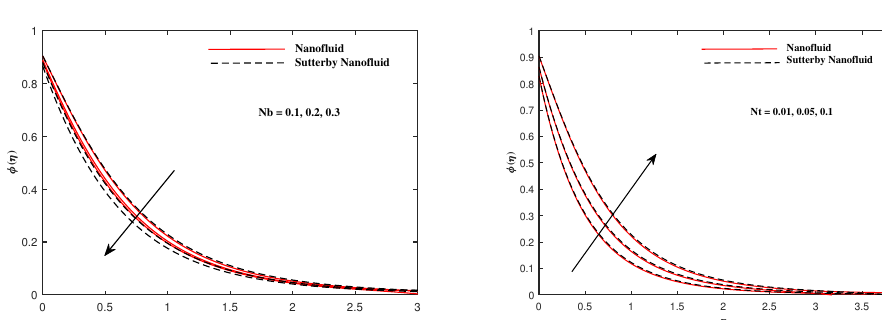
Figure 11. φ ( η ) fluctuate with Sc and A .